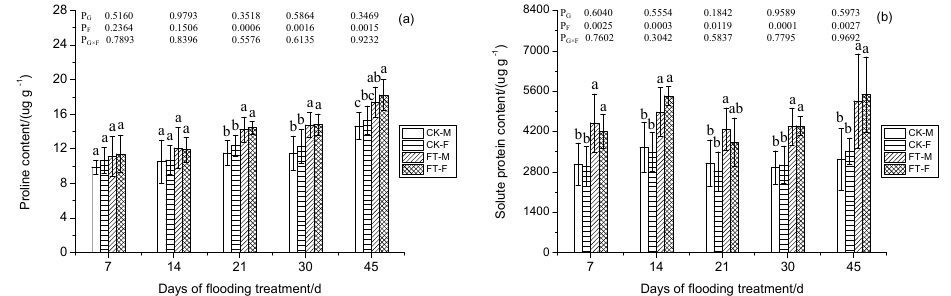
Figure 8. Proline (Pro) ( a ) and solute protein (SP) ( b ) contents of male vs. female Salix viminalis plants at di ff erent times of flooding treatment.